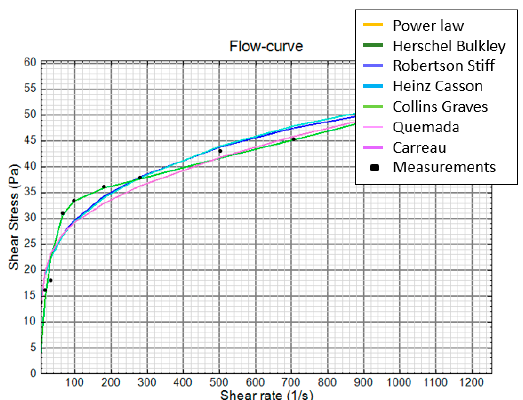
Figure 7. Flow curves for a bentonite based water-based mud (WBM). Here the best fit is obtained with the Collins–Graves model.